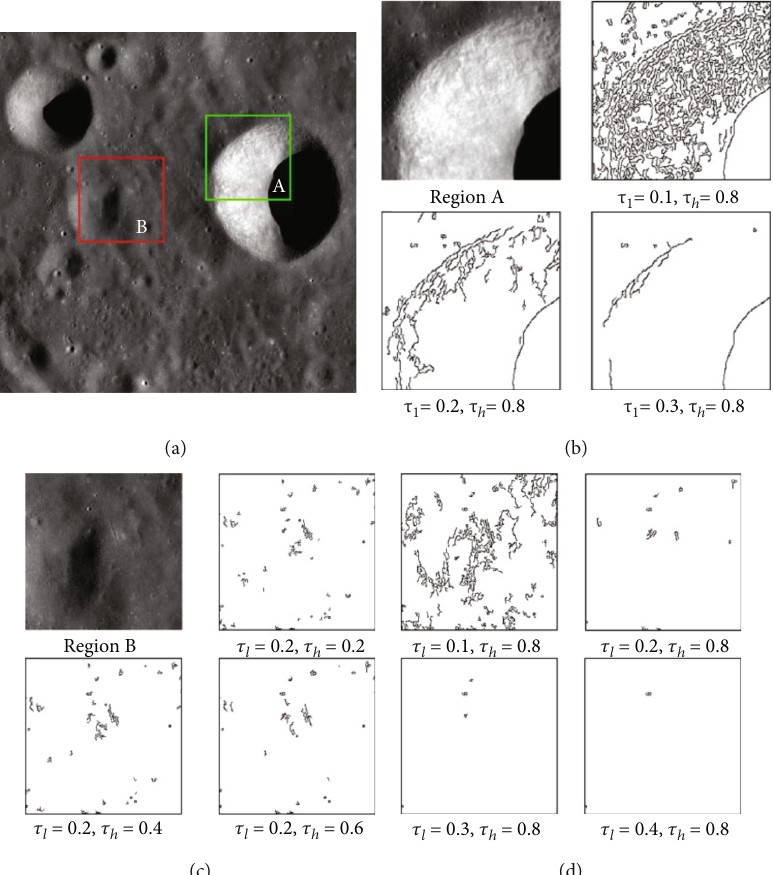
Figure 2: Performance and results for various values of high-threshold τ